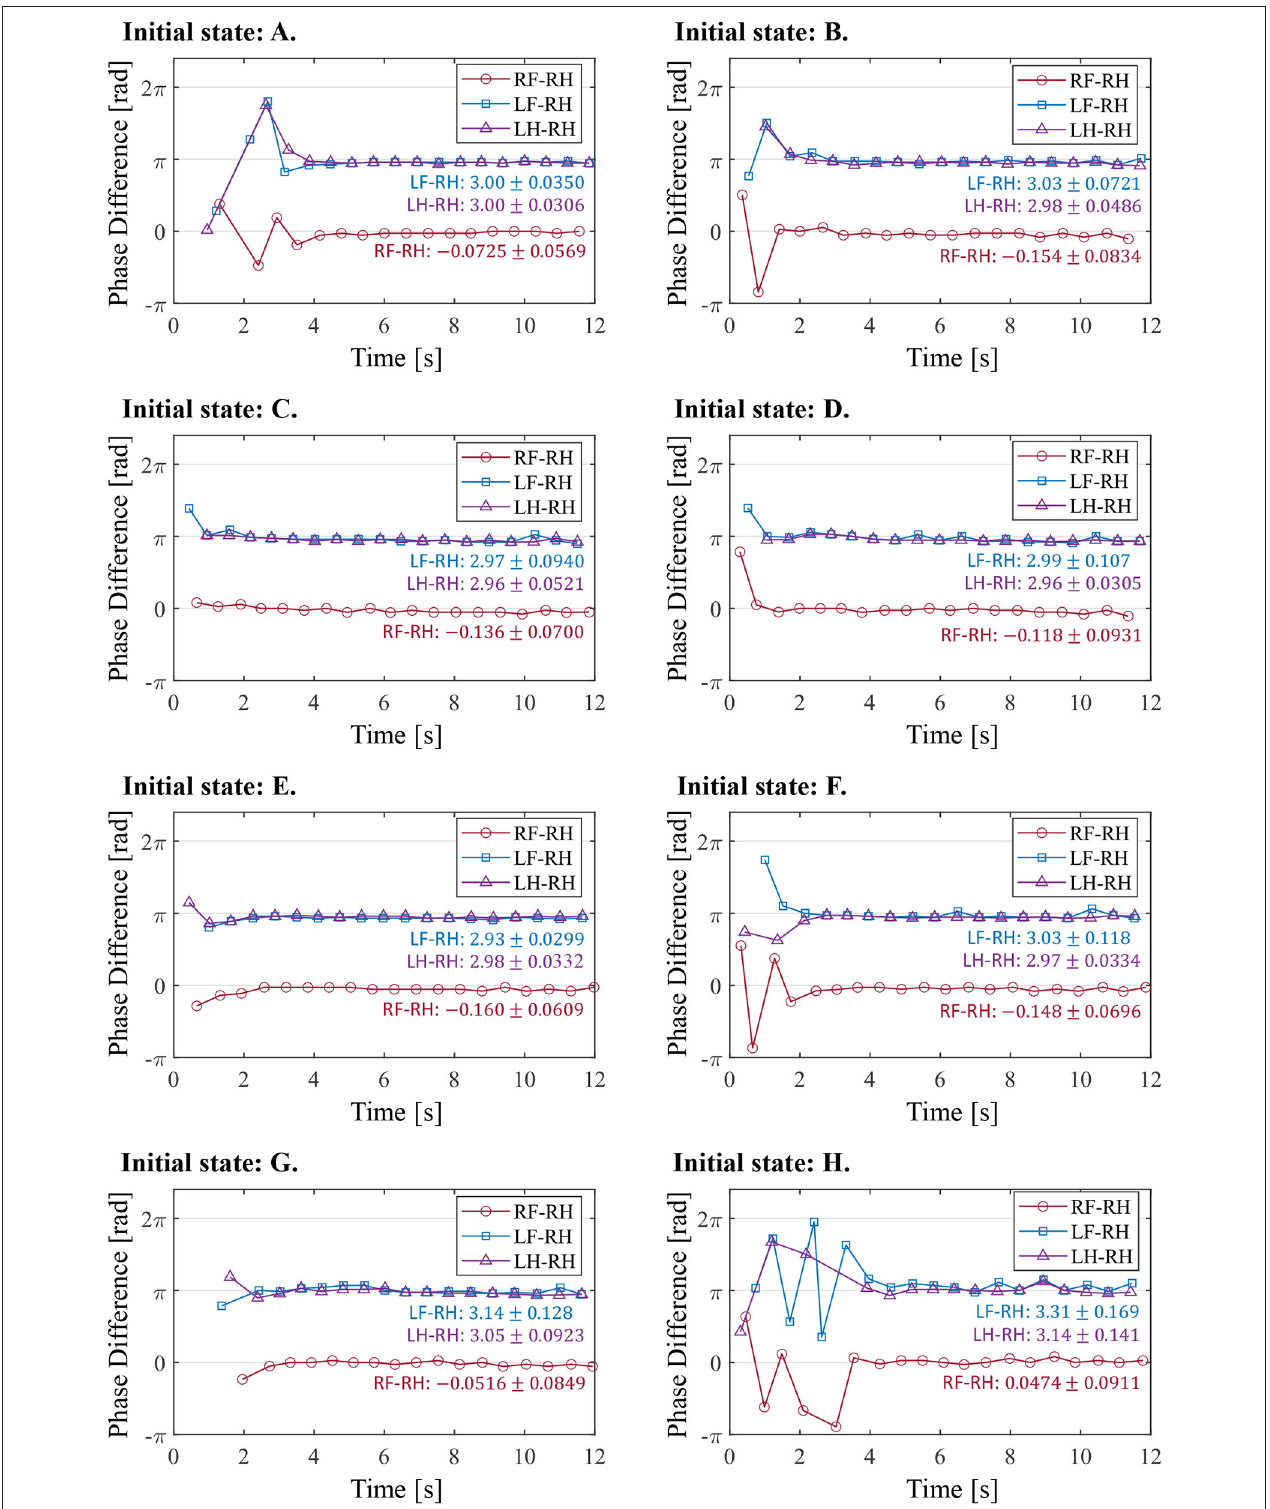
FIGURE 11 | The phase difference between each leg and the right hind leg in the experiment from the different initial conditions. The initial states (A–H) correspond with those in Table 2. The figure also shows the mean and standard deviation of each phase difference after 4 s, when the gait was stabilized.